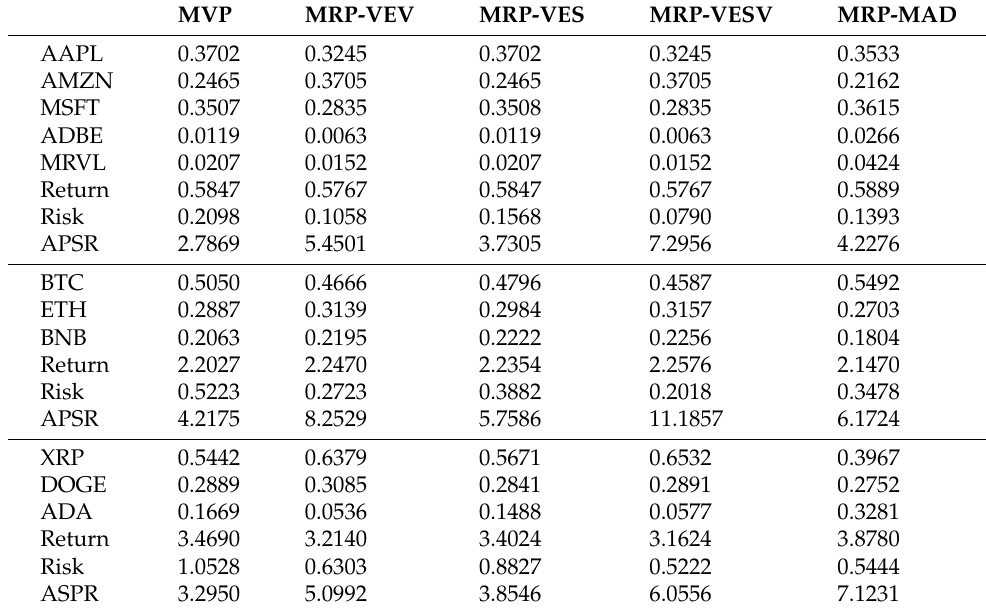
Table 2. Minimum risk portfolios of Stocks and